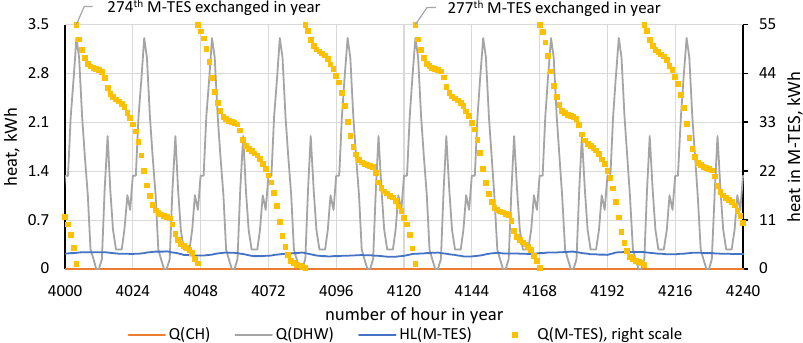
Figure 7. Heat demand and heat losses and heat accumulated in M-TES for each hour in the 4000–4240-hour period of the year (June).